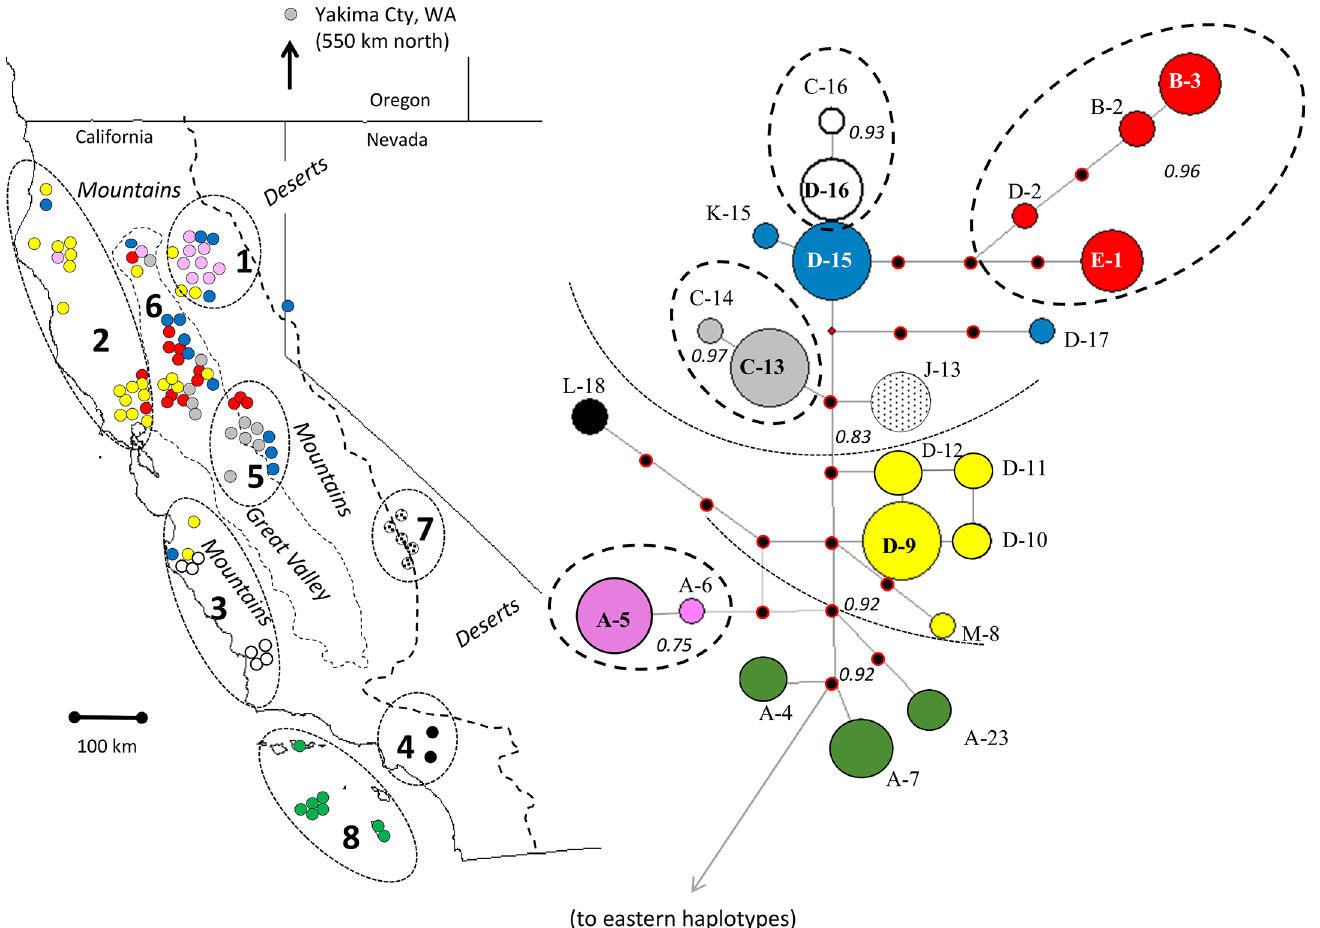
Fig 6. Median-joining network of 785-bp composite cytochrome b and D loop haplotypes. Haplogroups are color-coded for reference to map. Numbered samples correspond to those listed in Table 1. Haplotypes in green correspond to island foxes from Santa Cruz Island (A-4), San Nicholas Island (A-7), and San Clemente Island (A-23). All others represent gray foxes from the mainland. Dashed ellipses on network enclose nested tip clades and dotted arcs denote nesting clades according to the Bayesian tree (Fig 3), with Bayesian Posterior Support indicated with numerals in italics. Positioning of the root is in reference to the eastern haplotypes as indicated on the Bayesian tree (Fig 3). Nodes are approximately proportional to samples size for n < 10 (i.e., circle size was the same for n = 10 – 30). Inferred, unsampled haplotypes are marked with black and red